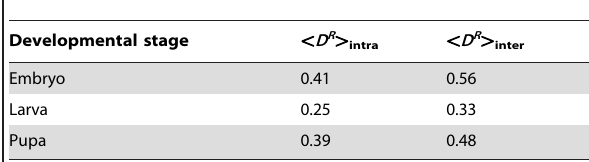
Table 1. Average distances D R (in A˚) between subprofiles within each cluster ( , D R . intra ) and between subprofiles of different clusters ( , D R . inter ) for the embryonic, larval and pupal stages of Drosophila .